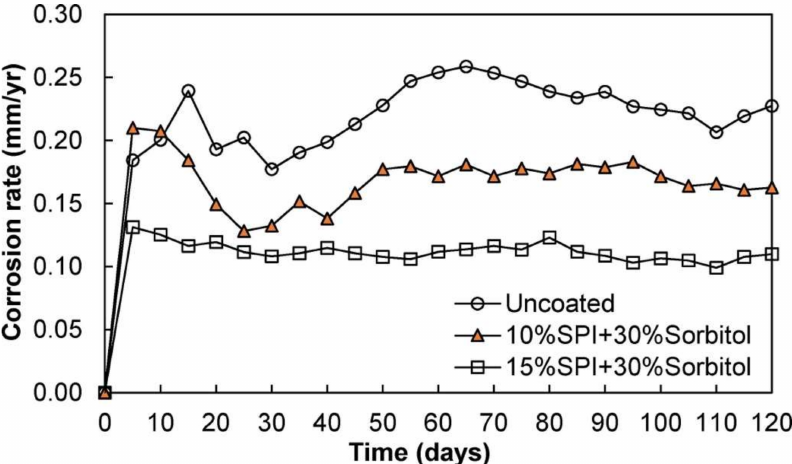
Figure 6. Corrosion rate for uncoated and coated rebars, employing coatings based on 10% and 15% soy protein isolate (SPI) and 30% of sorbitol. Reprinted from [79], with permission from Elsevier (November,